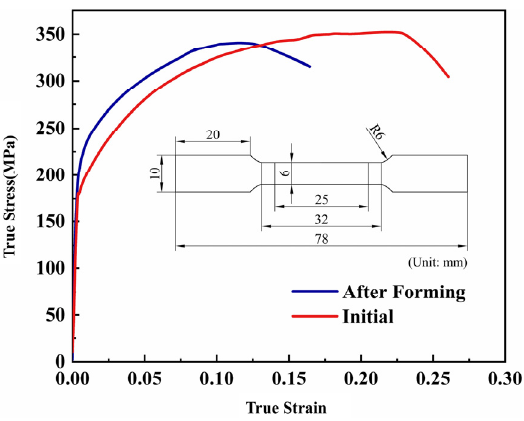
Figure 16. The geometry of the specimen for tensile tests and true stress–true strain curve of Al5083.